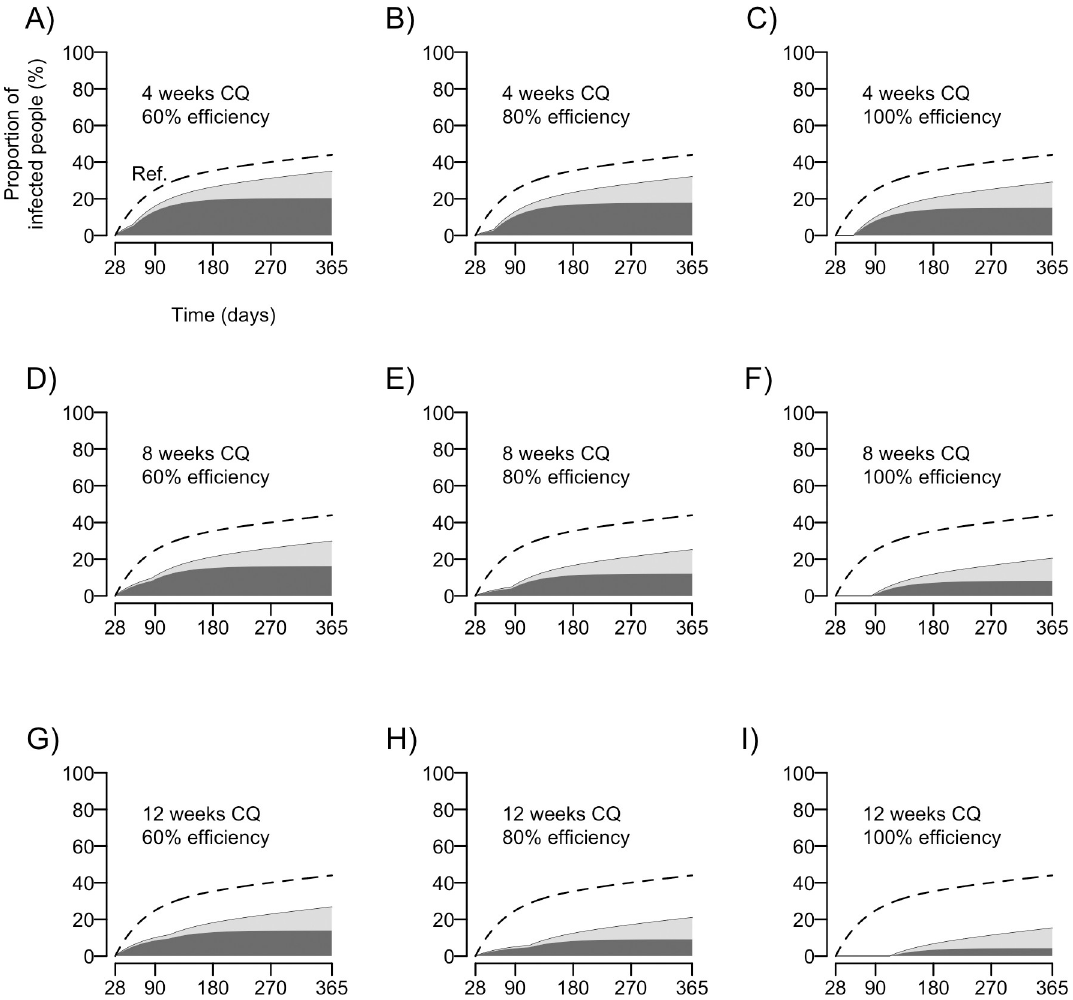
Fig 5. Simulation of the potential effectiveness of post-treatment chemoprophylaxis with weekly chloroquine (CQ) to prevent P . vivax recurrences after a primary infection. We considered scenarios with CQ prophylaxis being given over 4 (panels A, B and C), 8 (panels D, E and F) or 12 (panels G, H and I) weeks, being able to suppress 60% (panels A, D and G), 80% (panels B, E and H) or 100% (panels C, F and I) of blood-stage infections (regardless of its origin, whether hypnozoite- or mosquito bite-derived) during the period of administration. Dashed lines (“Ref.”) represent the scenario without intervention; the dark grey area represents the cumulative proportion of subjects with P . vivax relapses/recrudescences over time and the light grey area represents the cumulative proportion of subjects with new P . vivax infections.